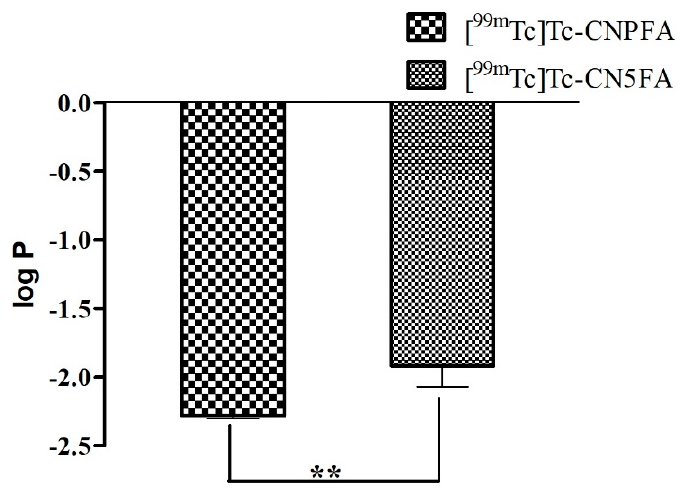
Figure 2. The log P of [ 99m Tc]Tc-CN5FA and [ 99m Tc]Tc-CNPFA (** p < 0.01).